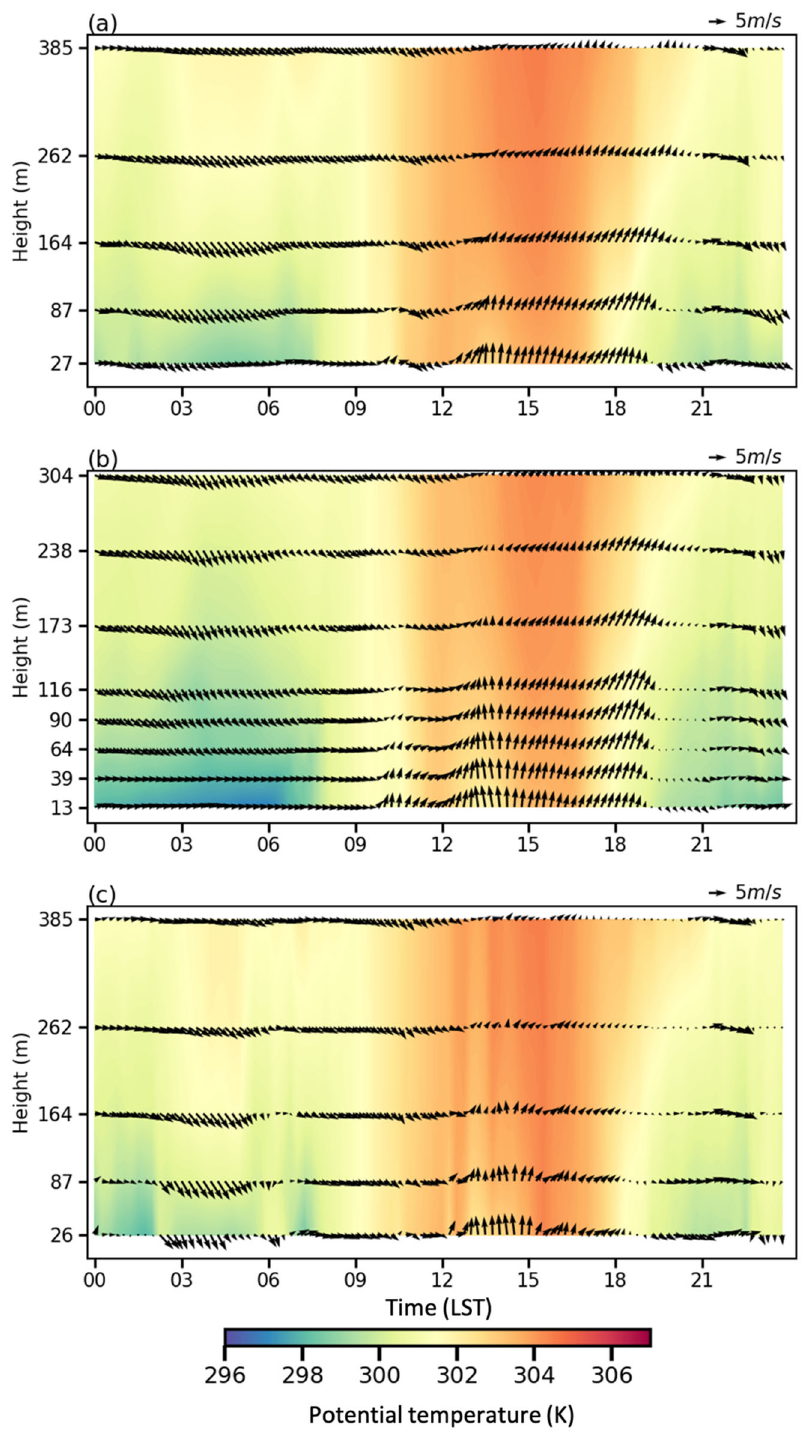
Figure 10. Time–height cross-section of simulated potential temperature (contours) and wind vectors: ( a ) S03, ( b ) S03V, and ( c ) S04. Table 5. The simulated characteristics of sea breeze on 15 July 2018.